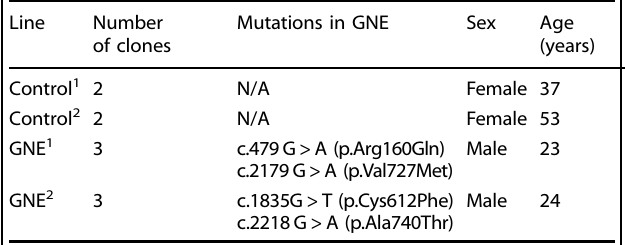
Table 1. Features of two healthy or GNEM patients of which iPSC lines were